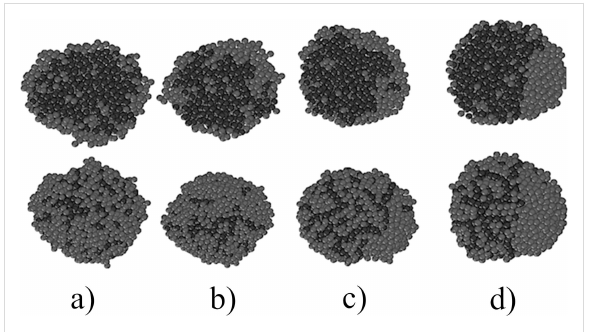
Figure 5: The structure of a Cu–Si nanocluster with a silicon content of 50 atom % at different times at a cooling rate of 0.002 K/ps after a) 0.75 ns, b) 7.5 ns, c) 75 ns, and d) 750 ns; top row: cross section, bottom row: outside